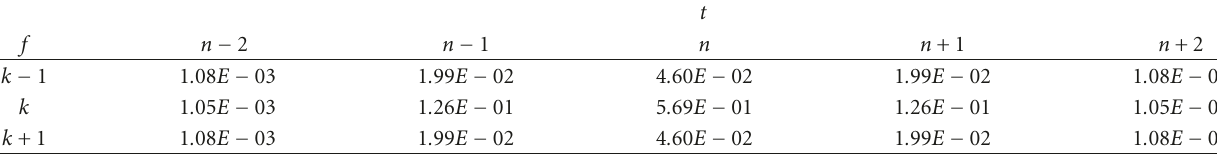
Table 2: Mean interference power table of FBMC.